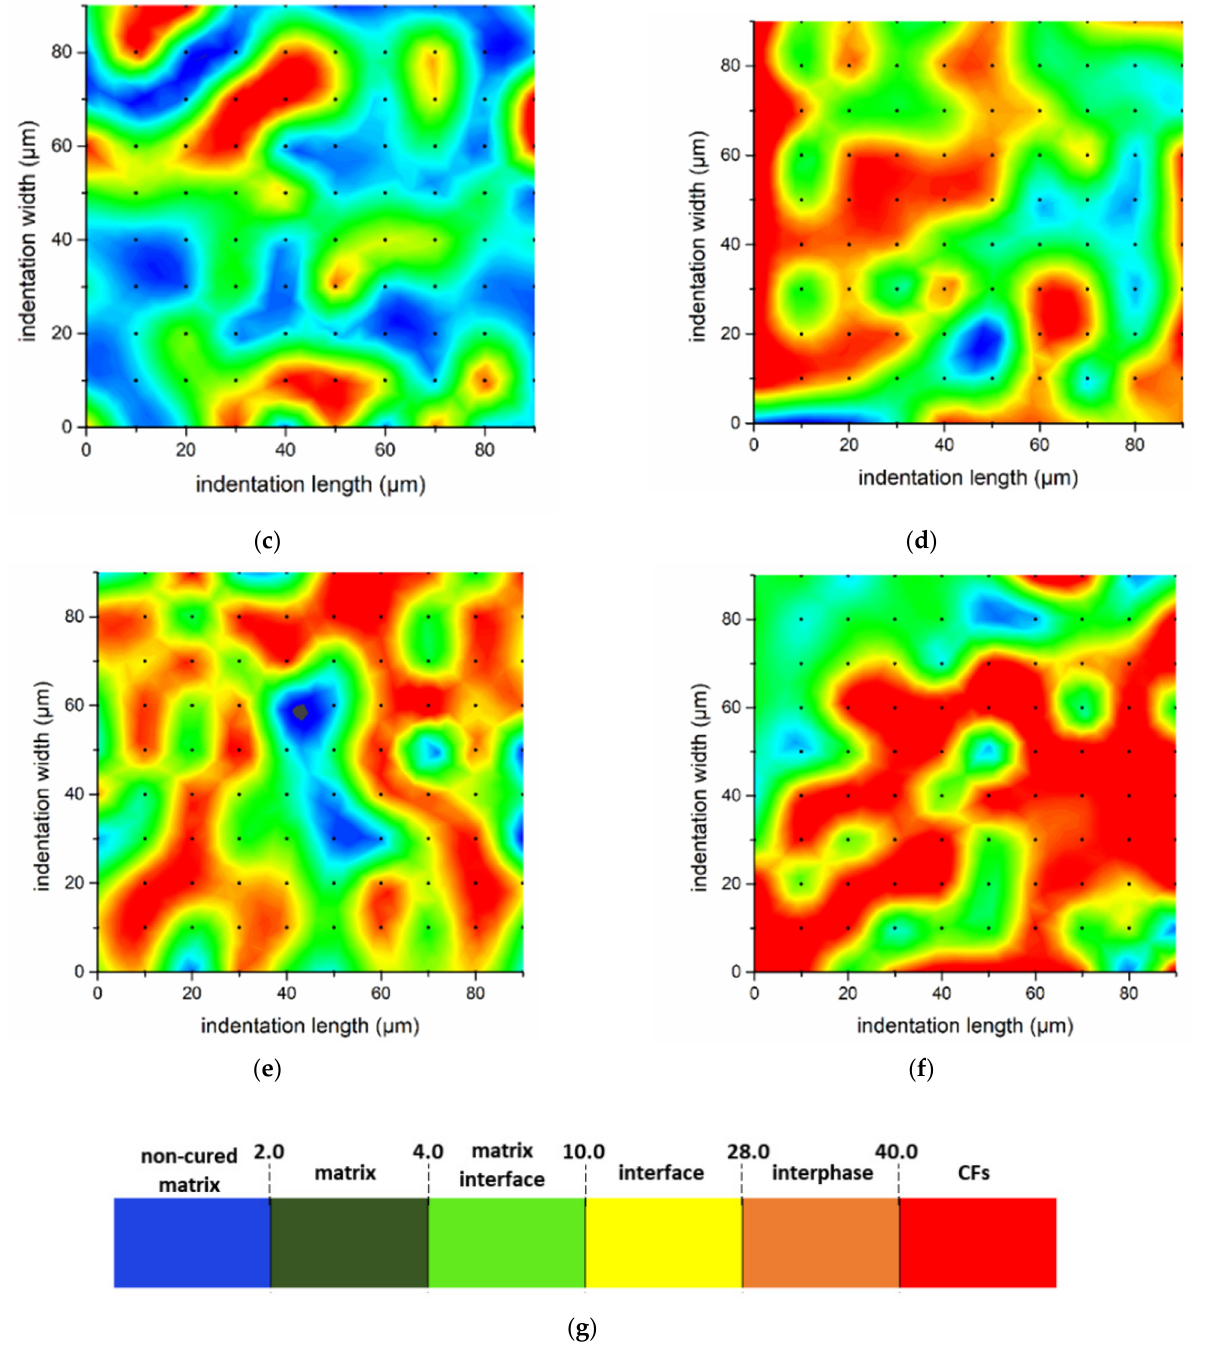
Figure 4. E r contour maps of CFRPs: ( a ) pristine, ( b ) W-pristine, ( c ) PMAA, ( d ) W-PMAA, ( e ) APP, ( f ) W-APP specimen. The memo of the contour maps is presented in ( g ).